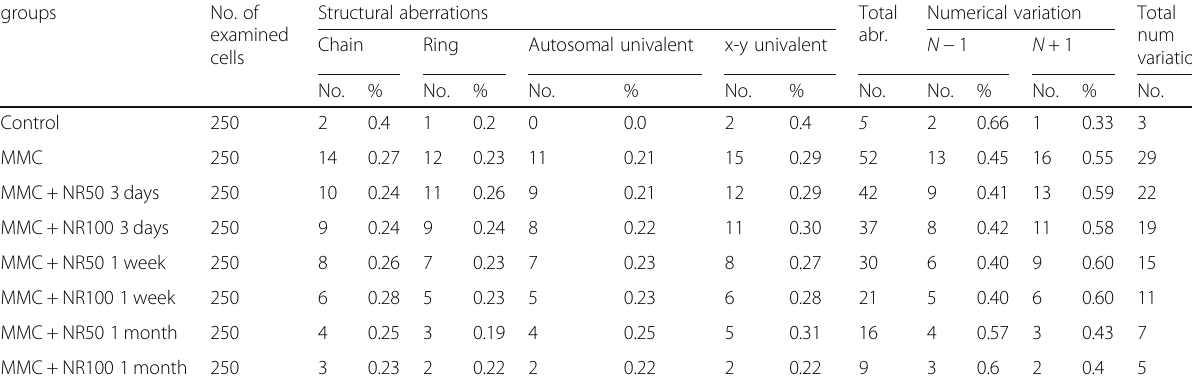
Table 3 Mean parentages of chromosomal aberration in spermatocyte cells of MMC-treated mice supplemented with different doses (50 and 100 mg/kg body wt) of Nitraria retusa leaf extracts at different time intervals (3 days, 1 week, and 1 month) groups